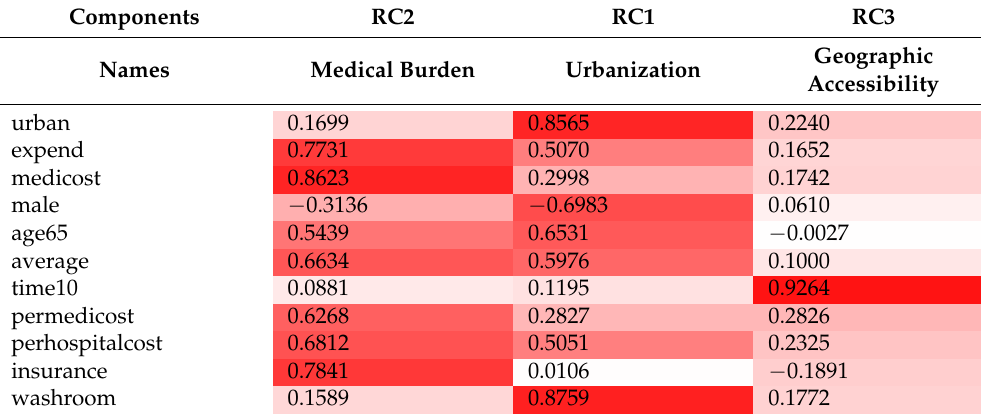
Table B2. Component loadings ( illnessday/chronicratio ).